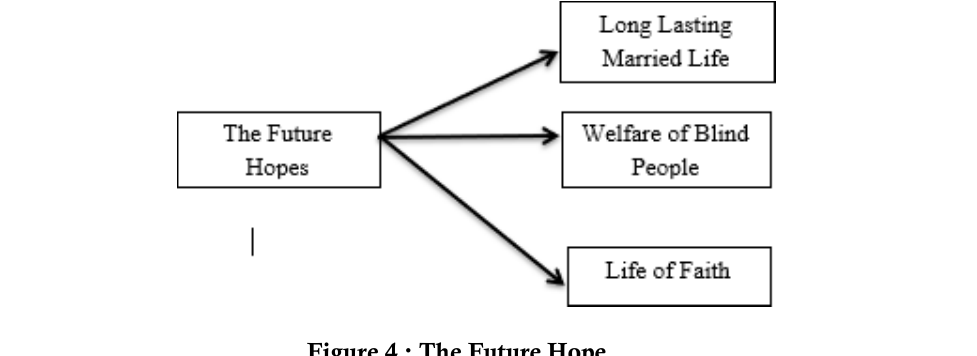
Figure 4 : The Future